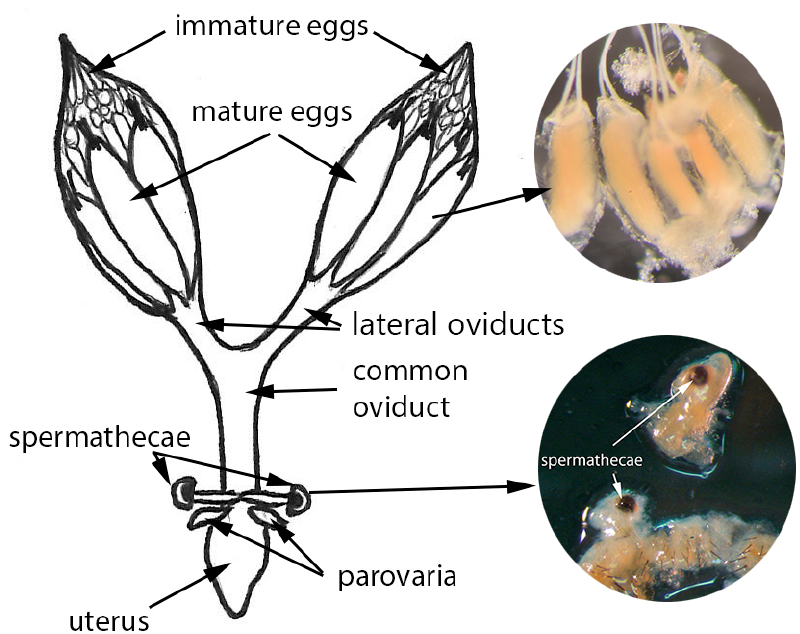
Figure 1. Scheme of Drosophila suzukii ‘s reproductive system from the dorsal perspective; the seminal receptacle is not shown due to its location on the ventral side of the common oviduct. (The drawing is by Claire Mattmiller; images by Kathryn Hietala-Henschell and Alina Avanesyan). It was demonstrated with D. melanogaster that, during mating, sperm is transferred from the uterus to the spermathecal reservoir and coils around the reservoir’s ‘center’ forming a toroidal mass [17]; the spermathecae can contain the sperm from multiple males and store it for up to two weeks